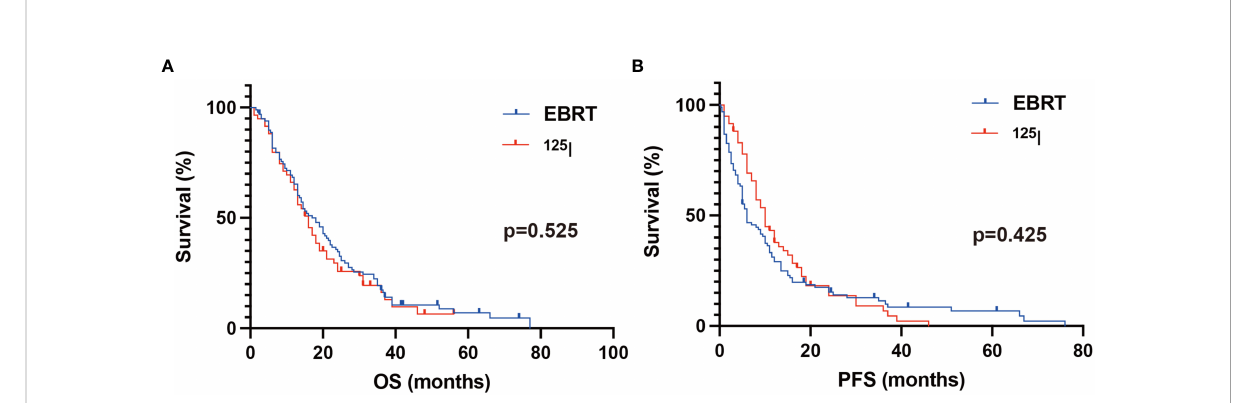
FIGURE 3 Kaplan – Meier analysis of OS and PFS. (A) The median OS was 18 and 16 months in the EBRT and 125 I groups, respectively. The log-rank test showed no statistical differences between the two groups ( p = 0.525). (B) The median PFS in the 125 I and EBRT groups was 10 and 6 months, respectively. No signi fi cant difference was found between the groups with a log-rank test ( p = 0.425).